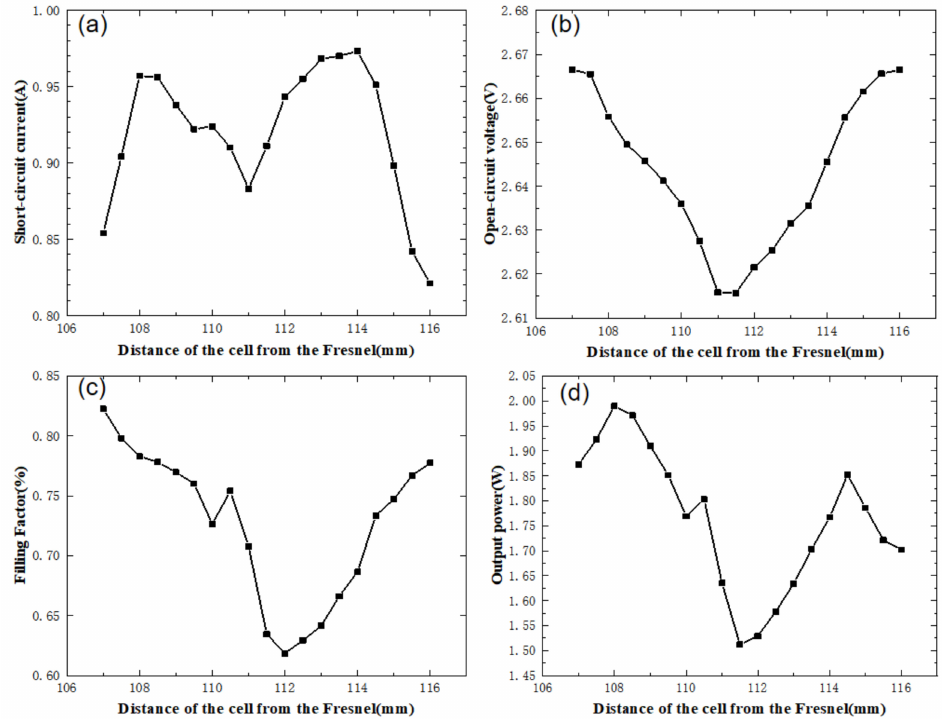
Figure 13. Variation in output parameters in the optical axis direction. ( a ) Short-circuit current; ( b ) Open-circuit voltage; ( c ) Filling factor; ( d ) Output